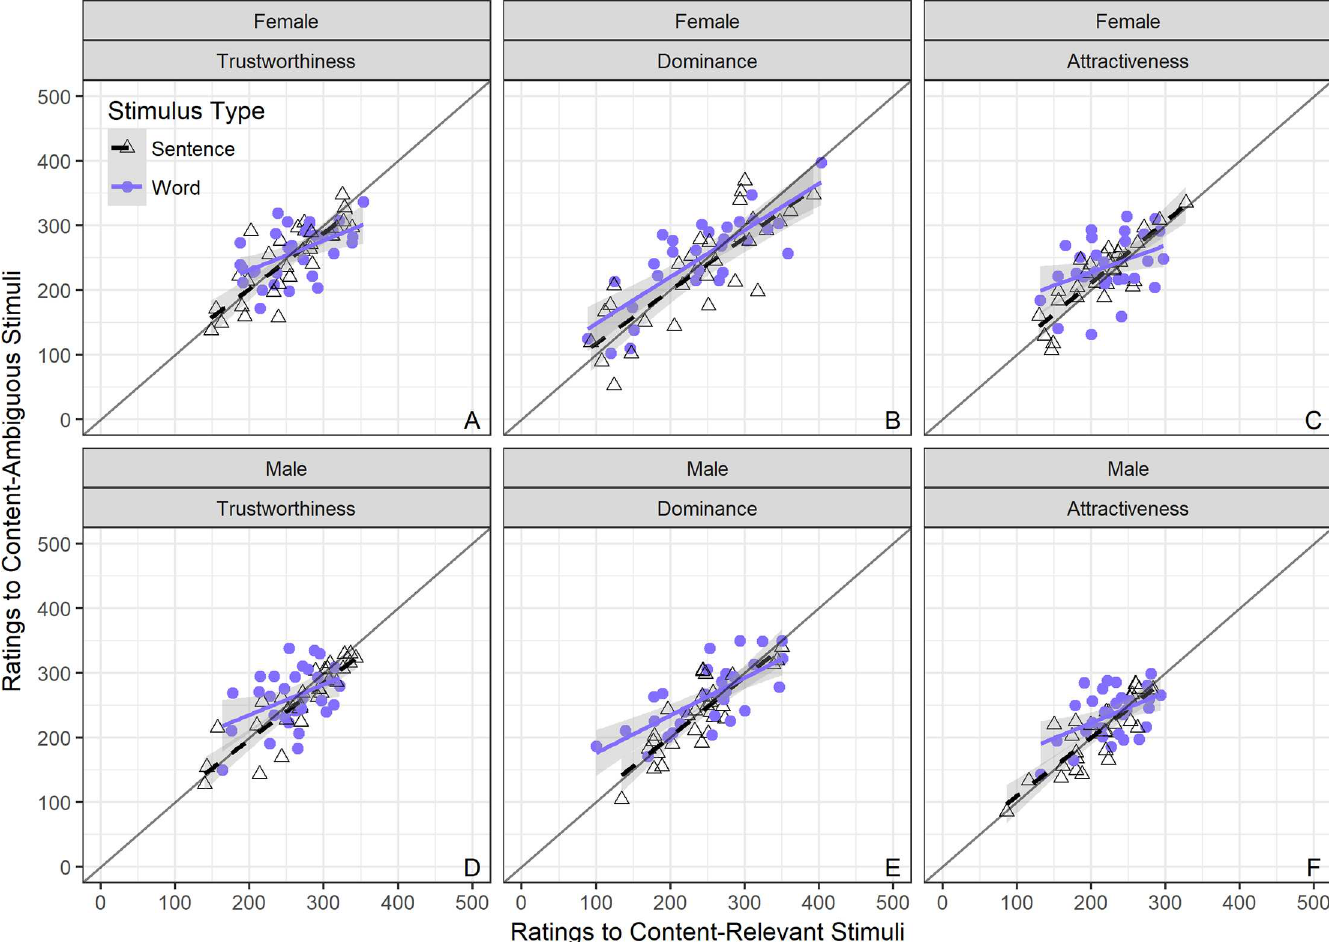
Fig 4. Scatterplots of VAS ratings for content-relevant versus content-ambiguous by stimulus type (word vs. sentence), in female (top) and male voices (bottom panels) for trustworthiness (left), dominance (middle), and attractiveness (right panel). Sentences (black dashed regression slope; open triangles represent individual voices) versus Words (blue solid regression slope; closed circles represent individual voices); grey line represents r = 1.